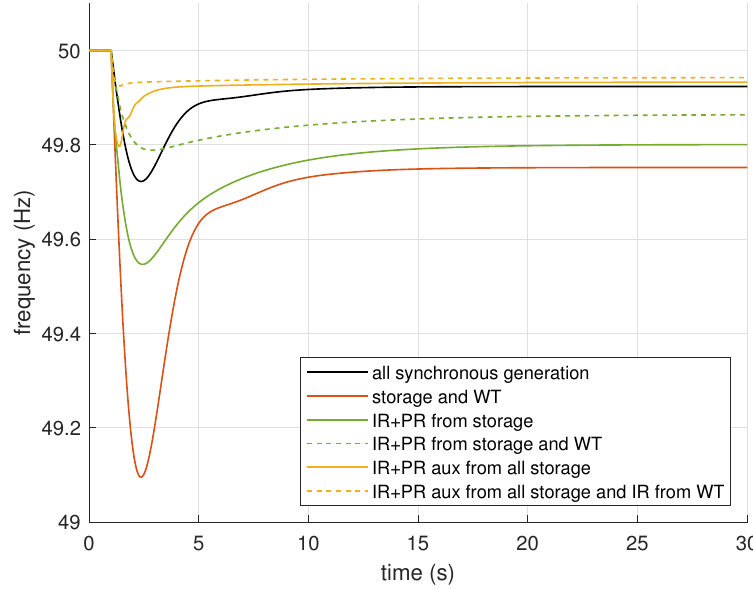
Figure 15. Results of scenario LL-HR (low load and high RES